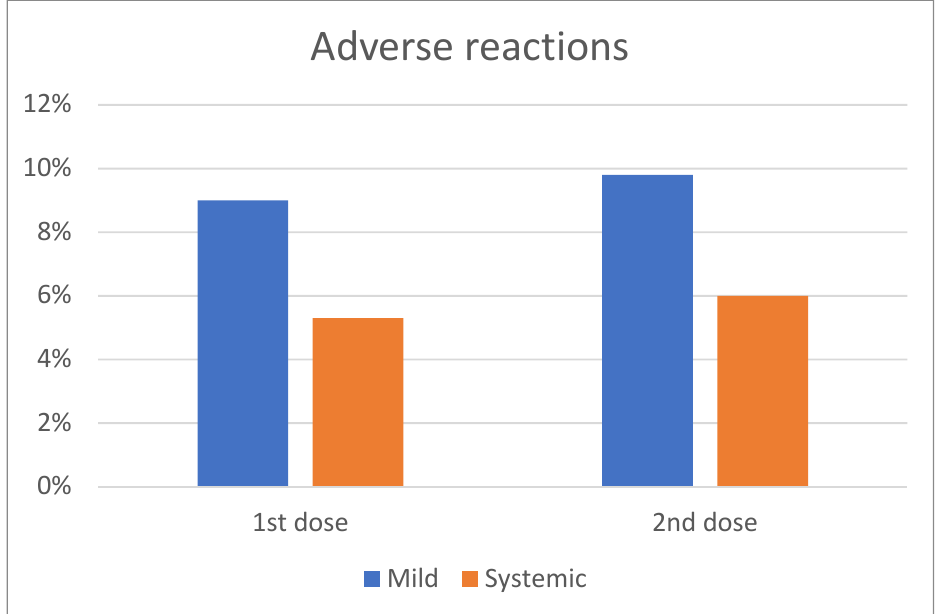
Figure 3. Frequency of mild and systemic adverse events following the first and second dose of COVID-19 vaccine.